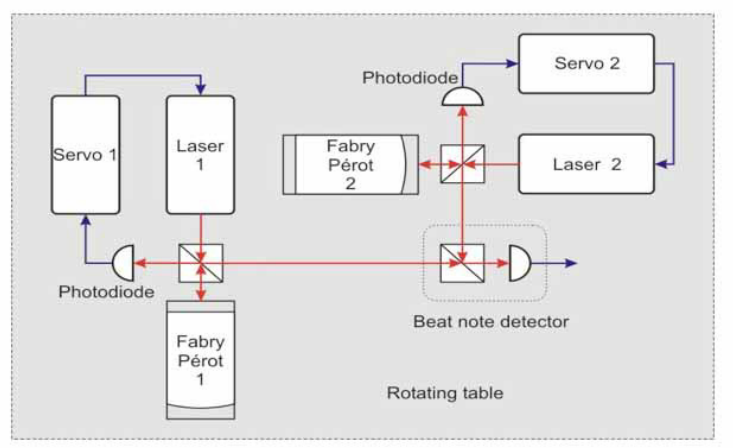
Figure 2. The scheme of a modern ether-drift experiment. The light frequencies are first stabilized by coupling the lasers to Fabry–Perot optical resonators. The frequencies ν 1 and ν 2 of the signals from the resonators are then compared in the beat note detector, which provides the frequency shift ∆ ν = ν − ν 2 1